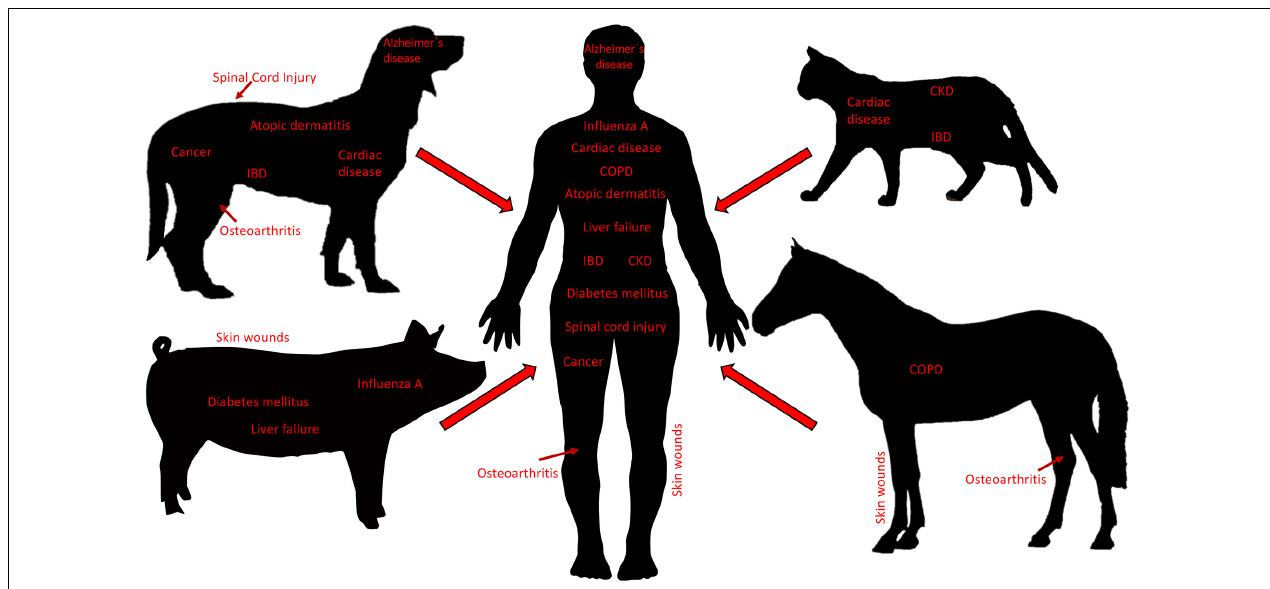
FIGURE 3 | Diseases in veterinary species as translational models for human disease. Small companion animals (i.e., dogs and cats), as well as large animals (i.e., pigs and horses), develop pathologies that are similar to diseases in humans and thus, are used as translational animal models for neurological, cardiac, pulmonary, musculoskeletal, nephrological, gastroenterological, dermatological, infectious, and cancerous, diseases. Body sizes are not to scale. IBD, inflammatory bowel disease; CKD, chronic kidney disease; COPD, chronic obstructive pulmonary disease. TABLE 5 | Small companion animal MSC secretome components, targets, effects, and potential therapeutic uses. Animal MSC source Secretome Targets: effects Therapeutic components